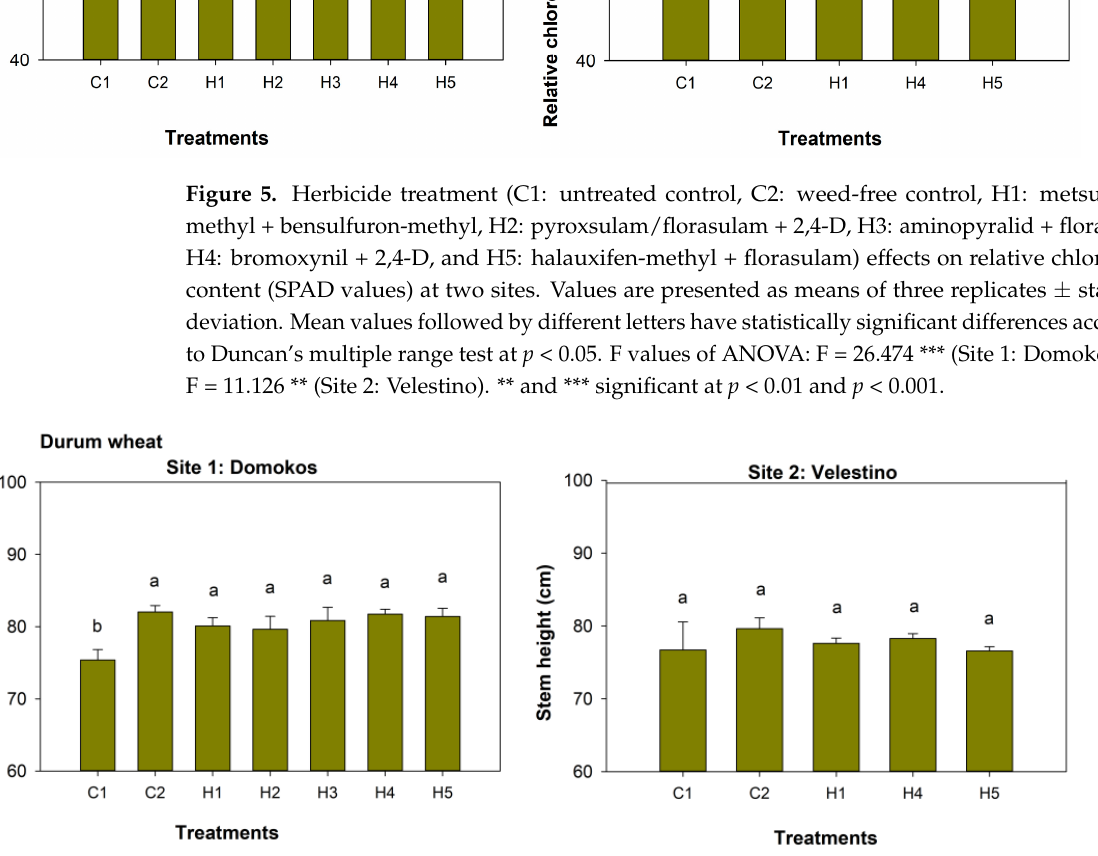
Figure 6. Herbicide treatment (C1: untreated control, C2: weed-free control, H1: metsulfuron-methyl + bensulfuron-methyl, H2: pyroxsulam/florasulam + 2,4-D, H3: aminopyralid + florasulam, H4: bromoxynil + 2,4-D, and H5: halauxifen-methyl + florasulam) effects on stem height (cm) at two sites. Values are presented as means of three replicates ± standard deviation. Mean values followed by different letters have statistically significant differences according to Duncan’s multiple range test at p < 0.05. F values of ANOVA: F = 10.100 *** (Site 1: Domokos) and F = 1.972 ns (Site 2: Velestino). *** significant at p < 0.001. ns = not significant. More specifically, at Domokos, the stem height of the plants in the herbicide treat- ments ranged from 79.6 cm to 81.7 cm with no statistically significant differences among them, but there were statistically significant differences between them and the untreated control (75.4 cm). At Velestino, in all treatments, this parameter ranged from 76.6 cm to 79.6 cm. In the case of dry biomass (Figure 7), at Domokos, the greatest biomass values (8508 to 8923 kg ha − 1 ) were found in plots where the herbicides bromoxynil + 2,4-D, ha- lauxifen-methyl + florasulam, and aminopyralid + florasulam were applied, with no sta- tistically significant differences between them and the weed-free treatment (8758 kg ha − 1 ). In the pyroxsulam/florasulam + 2,4-D and metsulfuron-methyl + bensulfuron-methyl plots, significantly and statistically lower values of dry biomass (7490 and 7203 kg ha − 1 ,